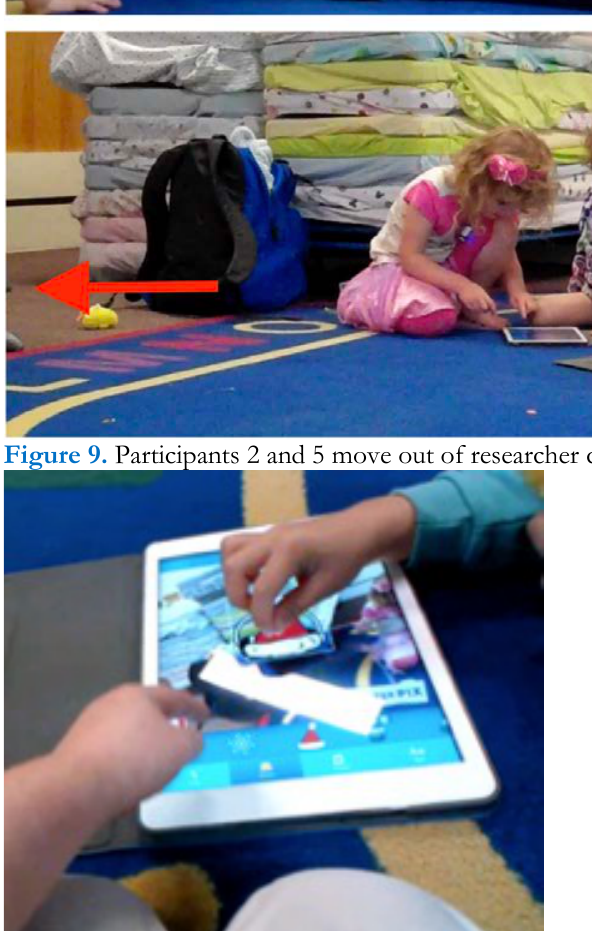
Figure 10. Participant 2’s point of view